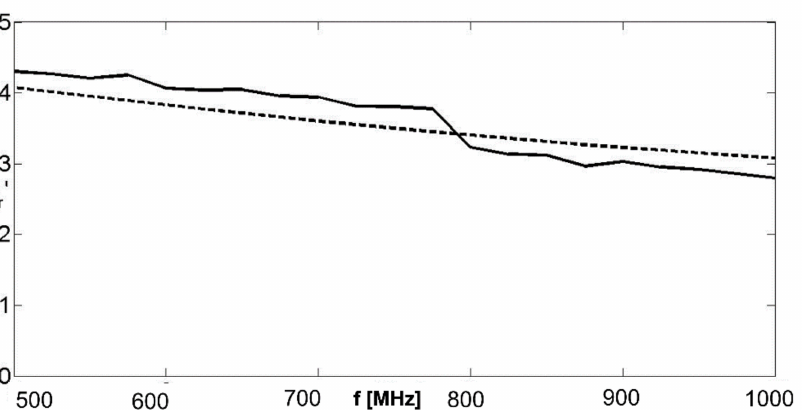
Figure 9. Real part of the equivalent complex permittivity for a Debye dispersion law. Solid line: retrieved value; dashed line: actual value. Noisy data with SNR = 20